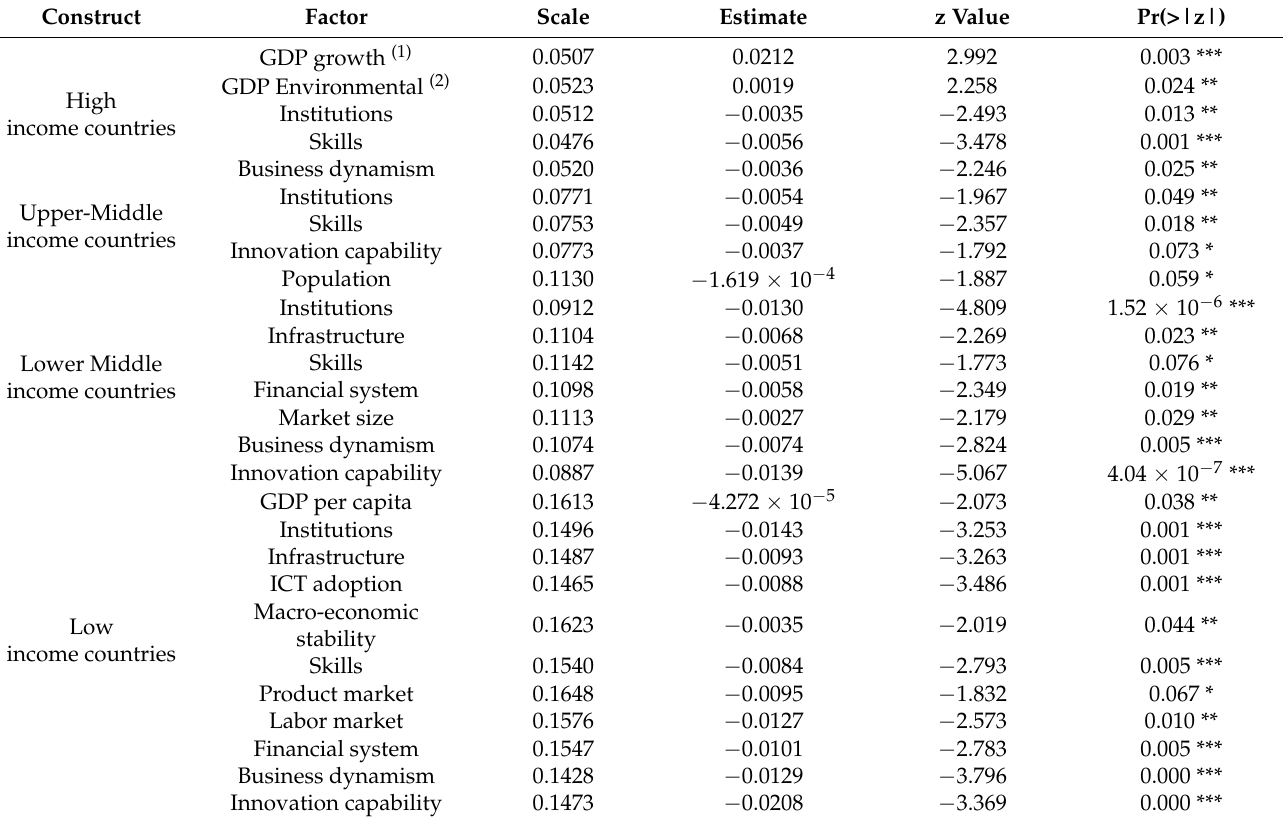
Table 6. Results of Tobit regression analysis of impact factors for